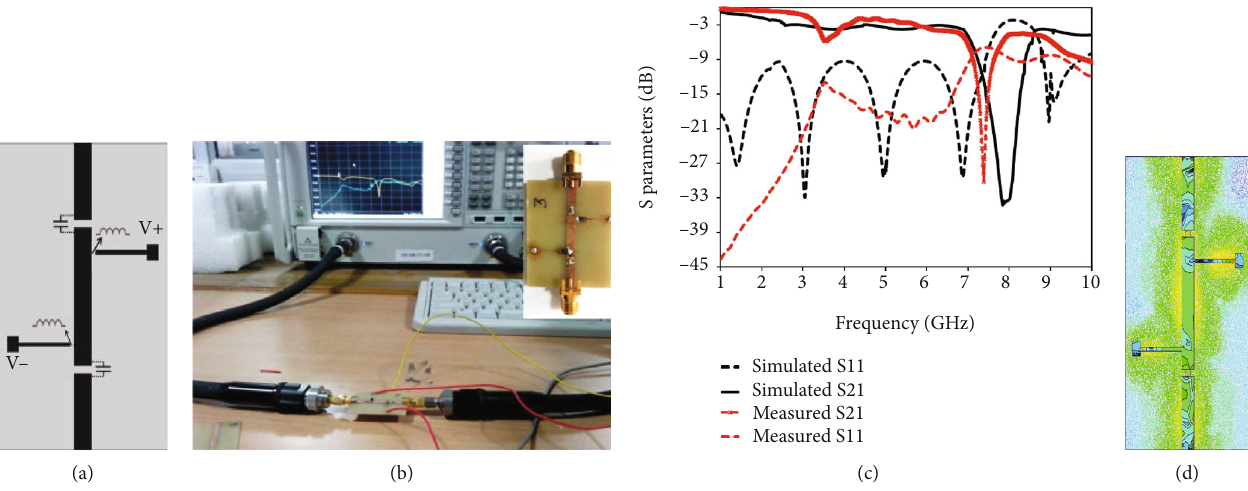
Figure 8: (a) RF choke under test; (b) measurement setup; (c) S parameter vs. frequency; (d) E fi eld distribution.